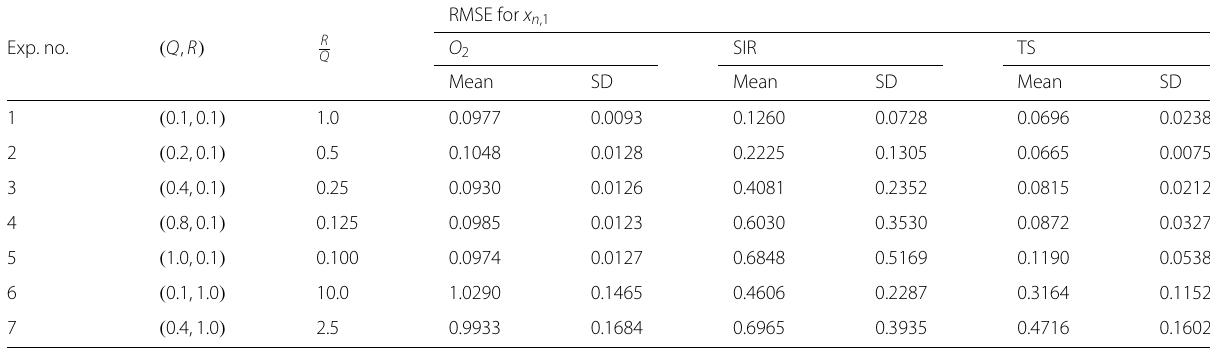
Table 4 Simulation results for Example 1: Mean and standard deviations of the RMSE for three different estimators of x n ,1 , namely, O 2 , the posterior mean based on SIR and the posterior mean based on TS Exp. no.